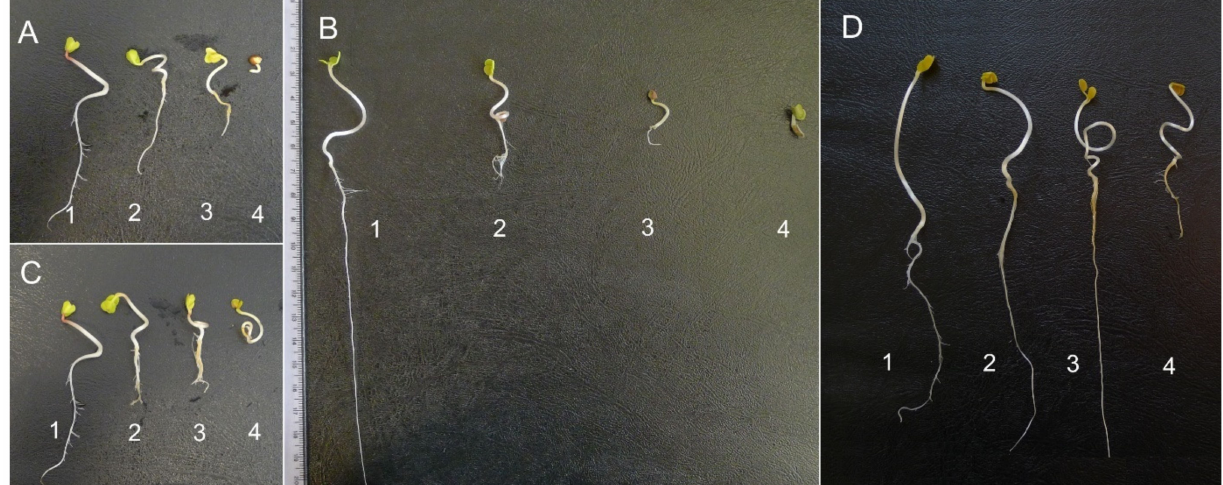
Figure 7. Seedlings of Raphanus sativus L. var. radicula Pers. cv. Rowa grown on aqueous extracts from the organs of Rosa blanda Aiton at various percentage concentrations (1%, 2.5%, and 5%); organs: ( A )—flower, ( B )—leaf, ( C )—stalk, ( D )—root; 1—control (distilled water); the influence of the extracts was analyzed separately at three weekly intervals, hence, the different control view, 2—1% extract, 3—2.5% extract, 4—5% extract (Photo Katarzyna